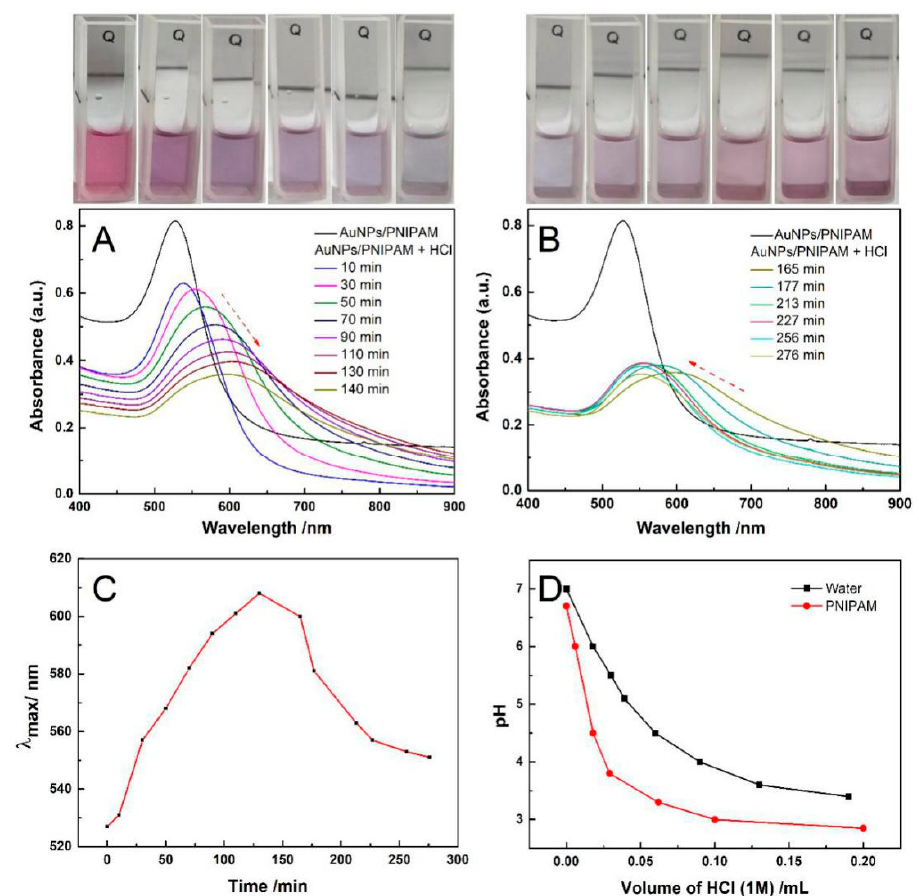
Figure 7. The change in the UV-Vis spectra with time for AuNPs-PNIPAM after addition of HCl (0.002 M) ( A , B ), the corresponding change in λ max with time ( C ), and acid titration curves for pure water and PNIPAM solution (3.47 × 10 − 6 mg/L mM) ( D ).